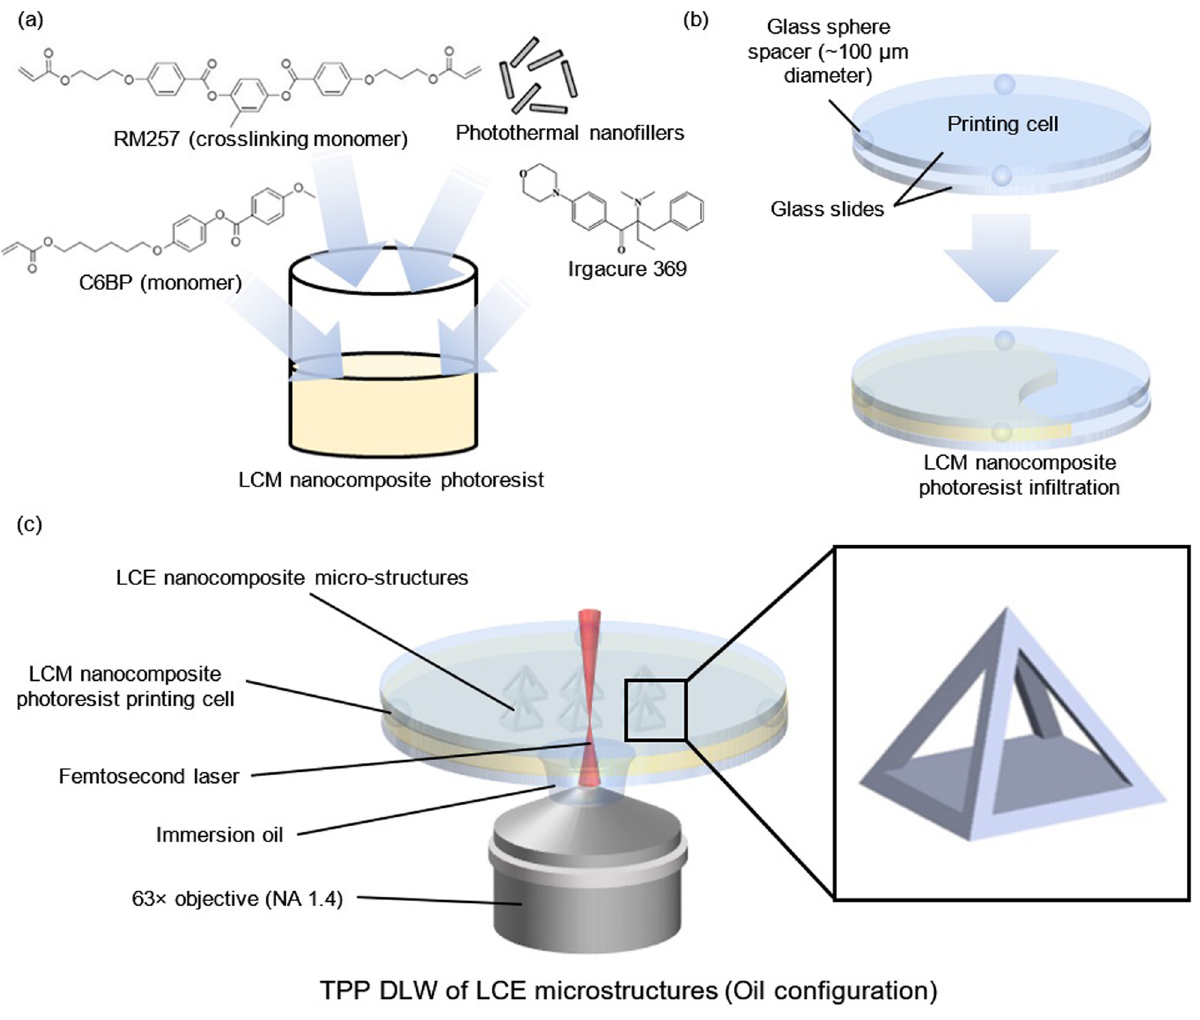
Figure 1: ( a ) Photothermal nano fi llers added to the mixture of LCM monomer, crosslinking monomer and photoinitiator to form LCM nanocomposite photoresist; ( b ) LCM nanocomposite photoresist printing cell assembly; and ( c ) TPP DLW of LCE nanocomposite micro - structures using femtosecond